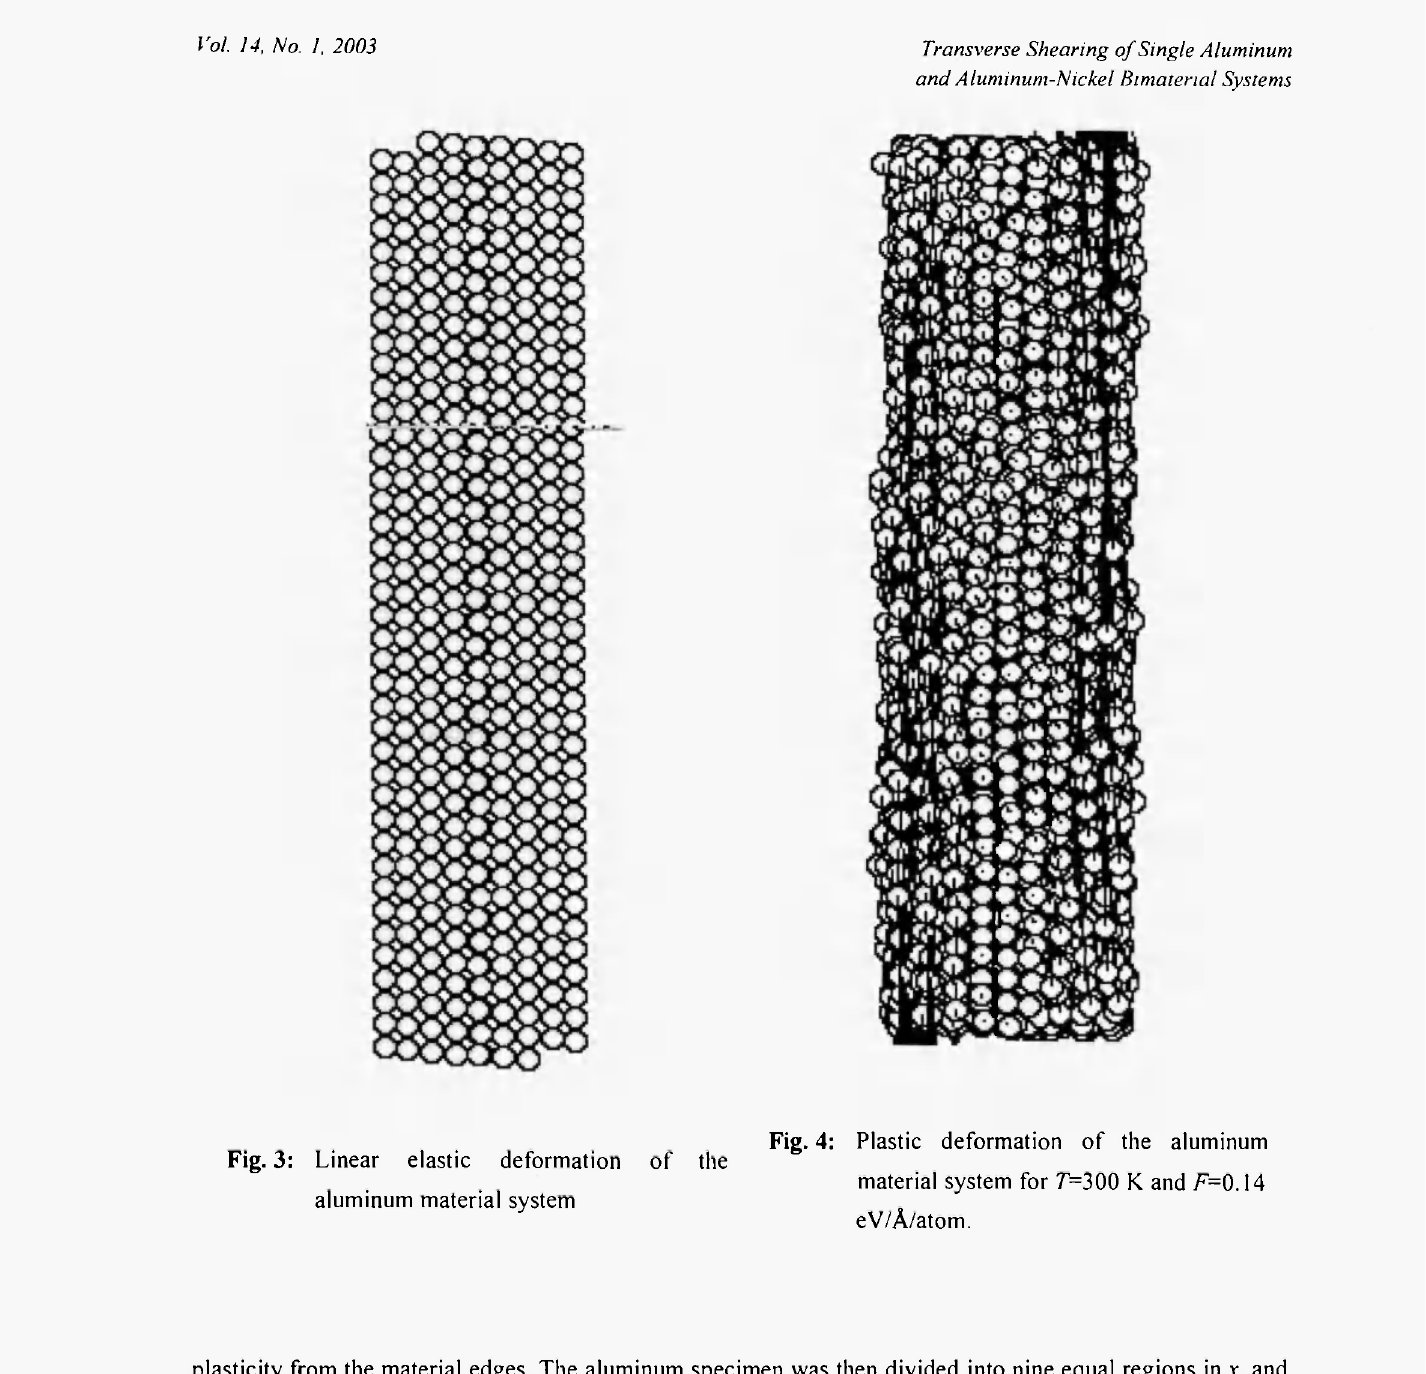
material system for 7=300 Κ and 7=0.14 eV /A